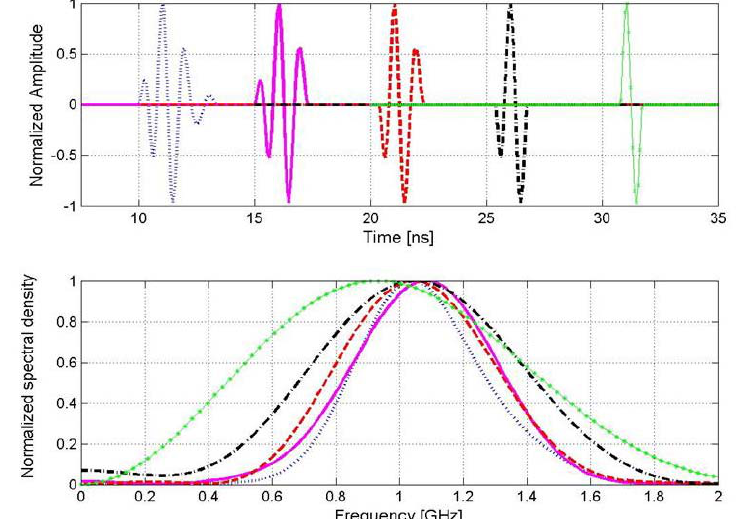
Figure 14. Evolution of the frequency spectrum as the pulse is confined within more stringent